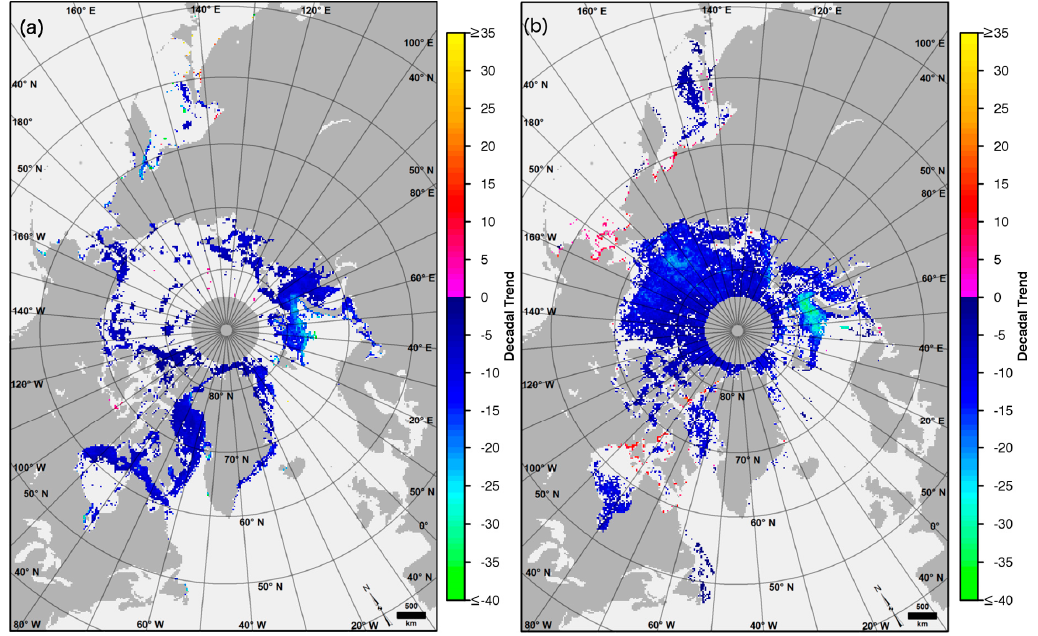
Figure 6. Statistically significant decadal trends (days·decade − 1 ) for ( a ) PMWC; and ( b ) AHRA MO dates over 1979–2012. Trends are significant at the 95% level. Areas with no data and insignificant trends are shown in white.